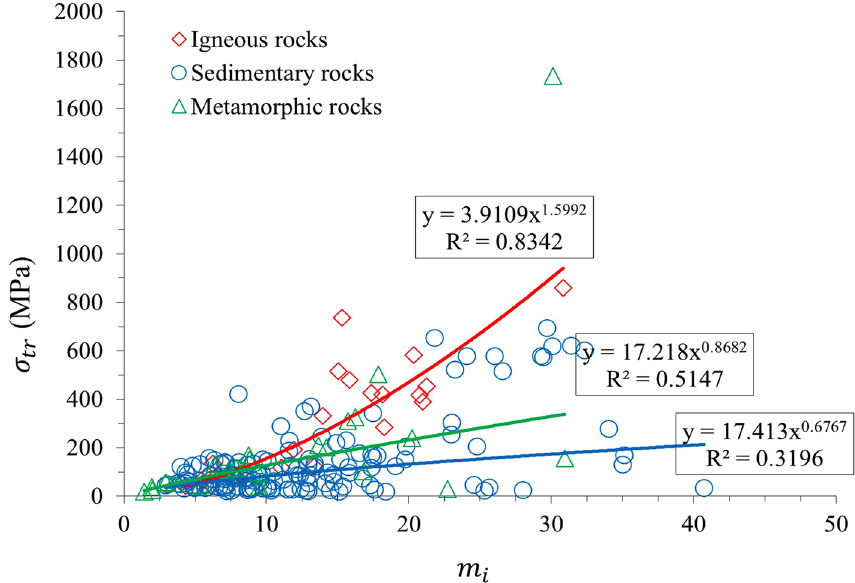
Figure 8. Relationship between σ TR and m i .